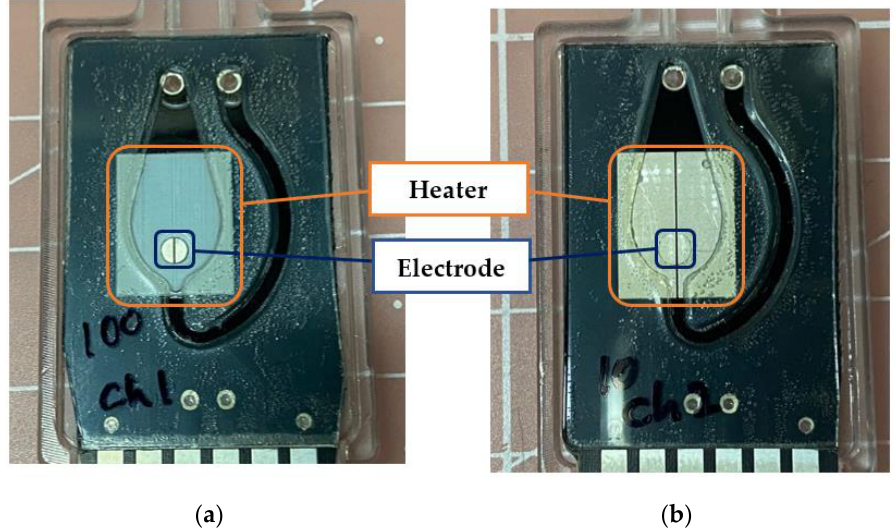
Figure 4. Two kinds of chips for impedance measurement. ( a ) A chip coated with white silk on the exposed electrode with a diameter of 2 mm made of tin and the heater pattern except for the electrode. ( b ) A chip in the form of exposing the electrode by making a hole 2 mm in diameter on the printed circuit board on which both the heater pattern and the electrode are gold-plated.